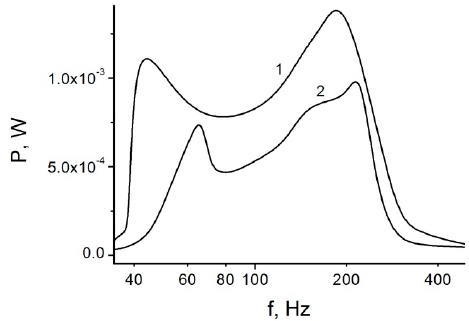
Figure 7. Generator power as a function of external vibrations frequency. k = 2 × 10 5 N/m, k 0 = 2 × 10 3 N/m, a 0 = 5 g, R = 3 × 10 5 Ω , d 1 = d 0 = 17 μm, S = 1 cm 2 . V P = 293 V ( 1 ), 225 V ( 2 ).